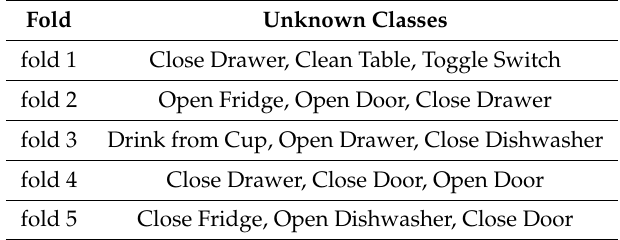
Table 2. Foldings of the OPP